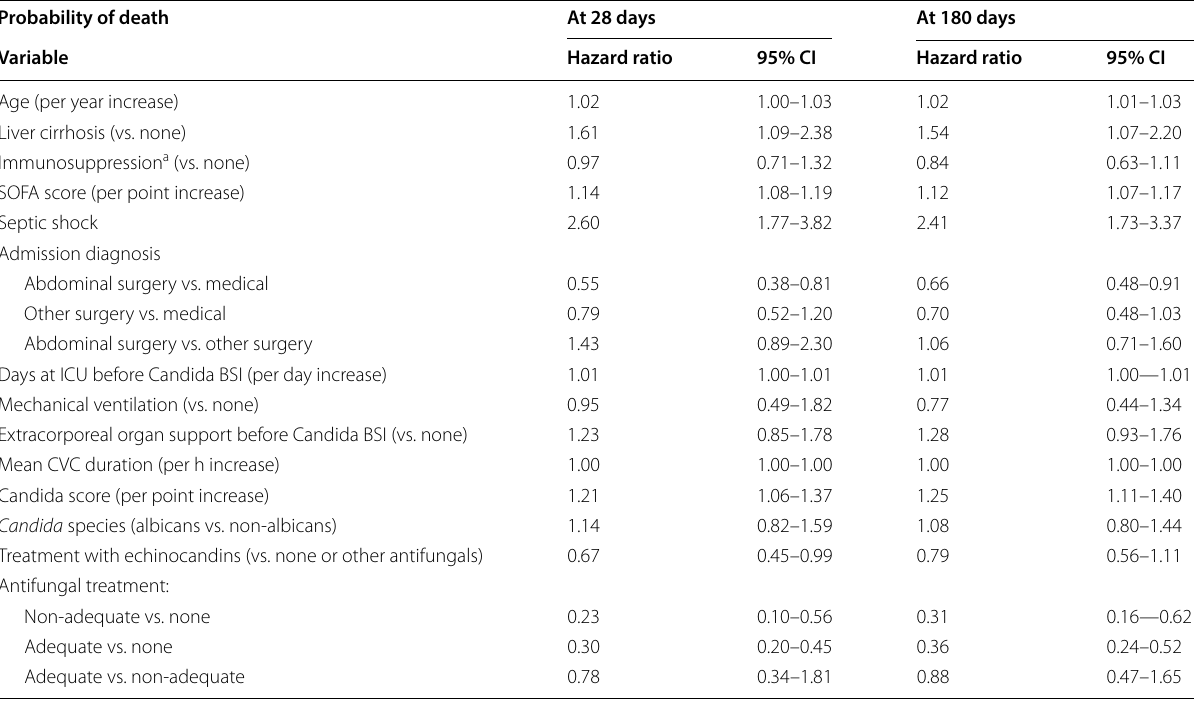
Table 3 Probability of death 28 and 180 days after blood cultures were tested positive for Candida spp. 381 observations, 178 events (28 days), and 227 events (180 days) were included in the multivariable